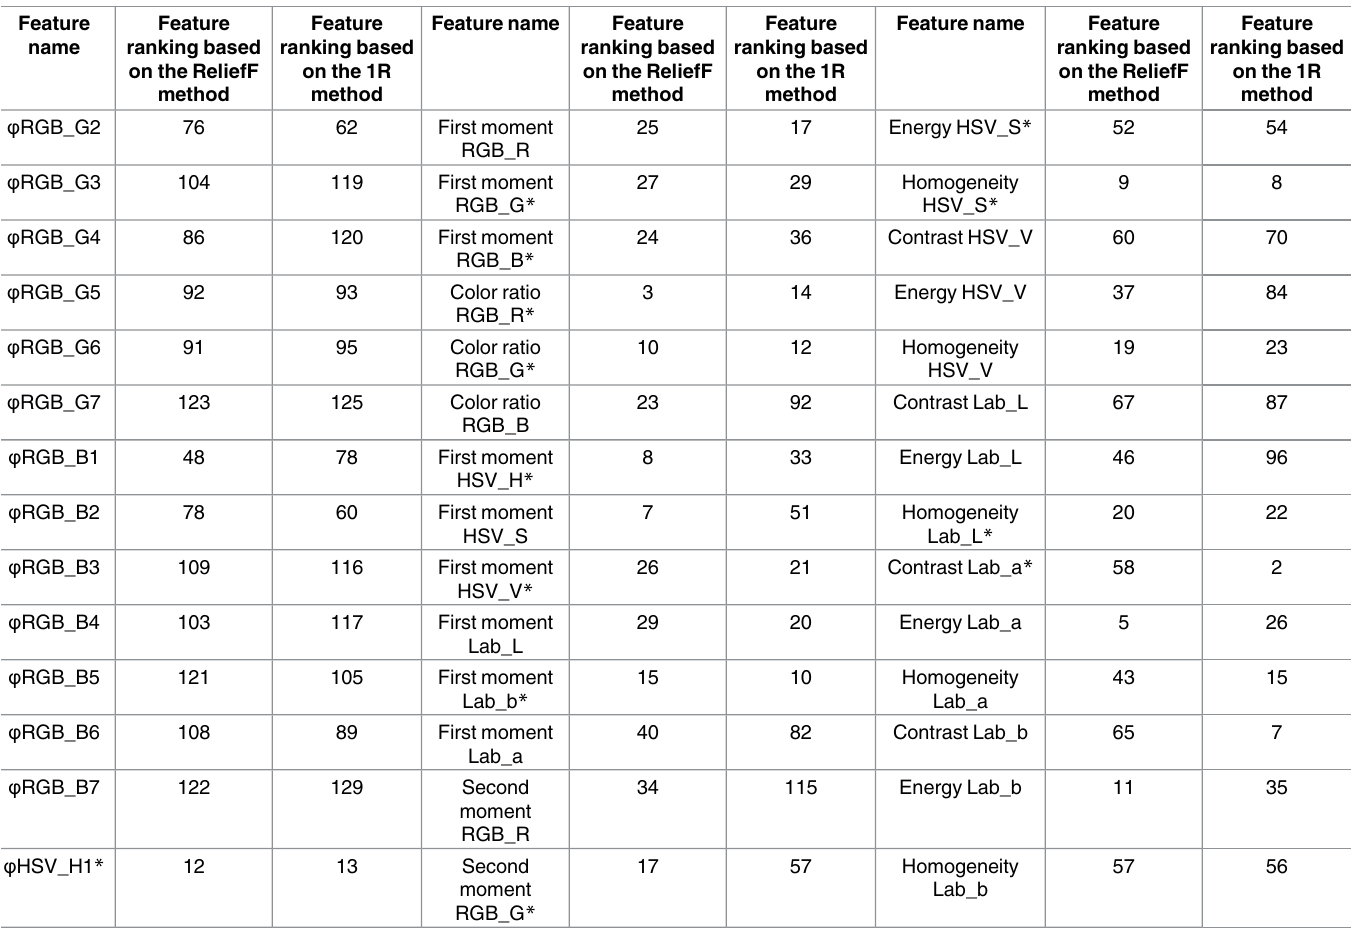
Model 8. For Model 8, the recognition accuracy of the training set was 92.36% and the recogni- tion accuracy of the testing set was 88.93%. When the CFS method was used to select features, built KNN models fluctuated by 0.18%-2.09%. Based on the 21 selected features, the